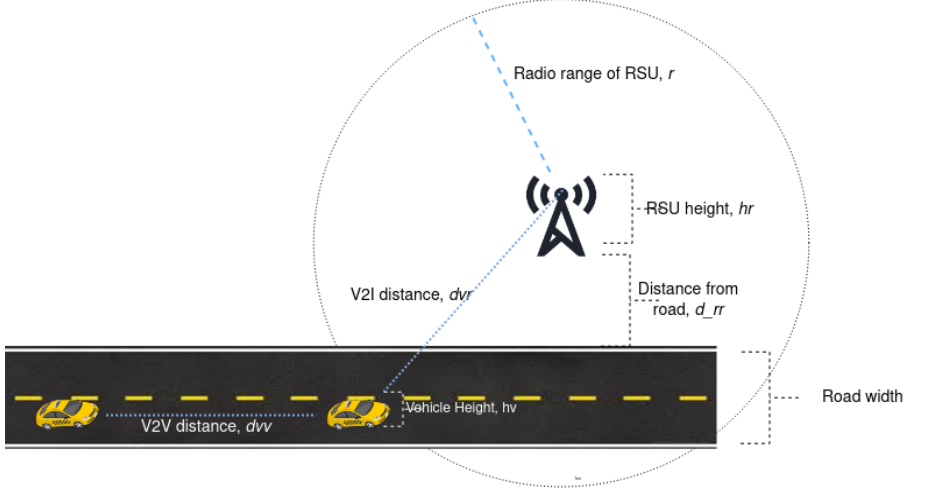
Figure 3. Position of vehicles and